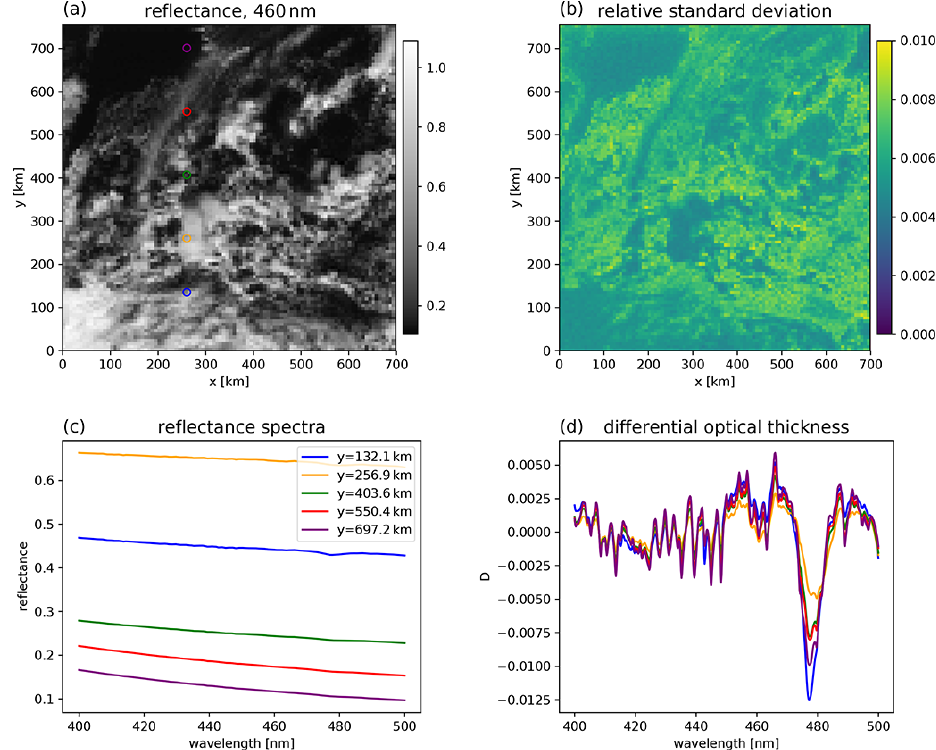
Figure 11. (a) Reflectance at 460nm at a spatial resolution of about 7km × 7km, (b) relative standard deviation of reflectance, (c) reflectance spectra for the pixels marked by circles in the reflectance image and (d) differential optical thickness calculated from the reflectance spectra.